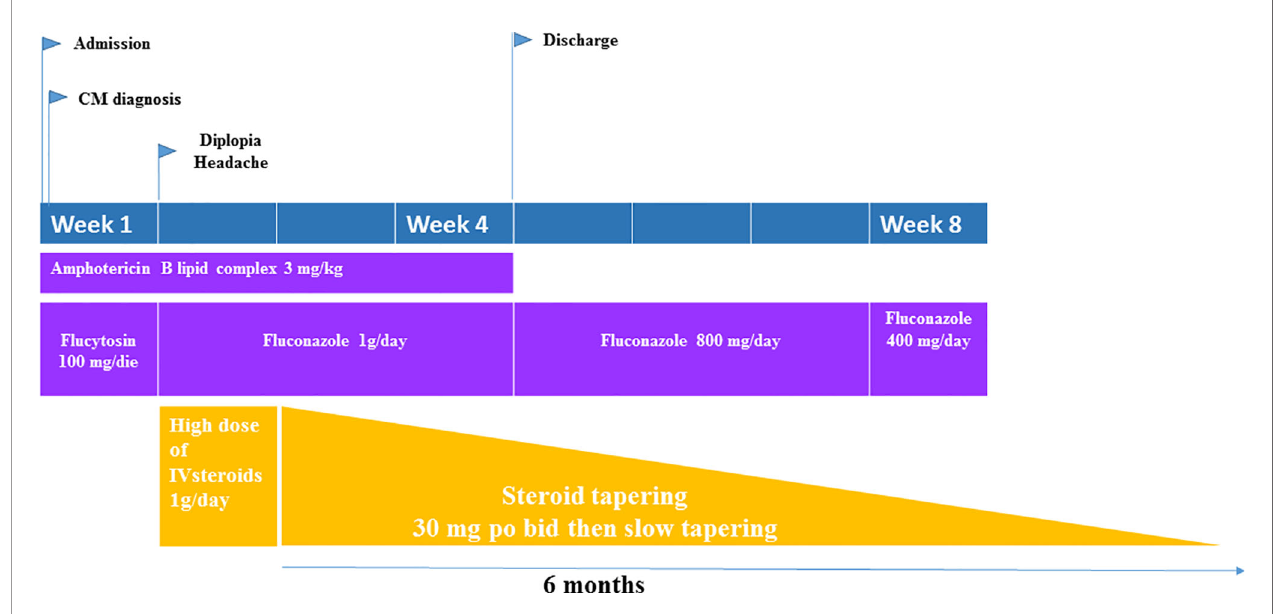
FIGURE 2 | Graphical representation of CM therapy in our patient.